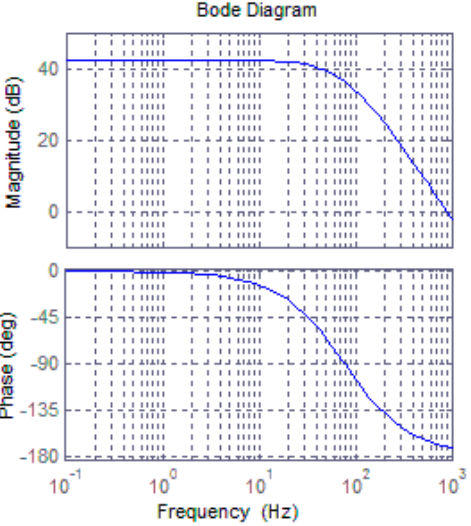
Figure 19. Bode diagram of the rebalance loop’s linearized model.